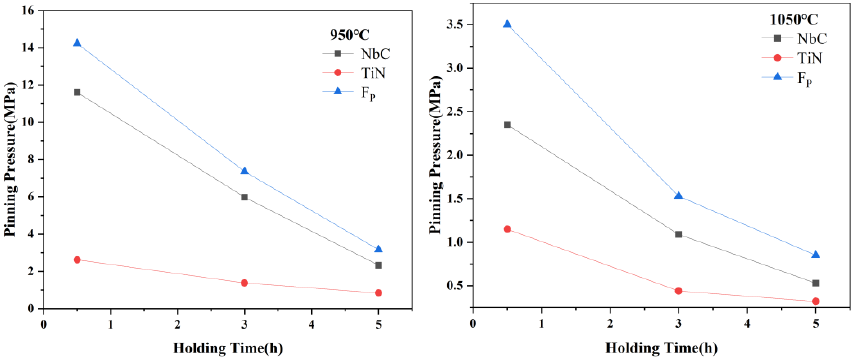
Figure 12. Pinning pressure of precipitates at different isothermal austenitizing treatments.